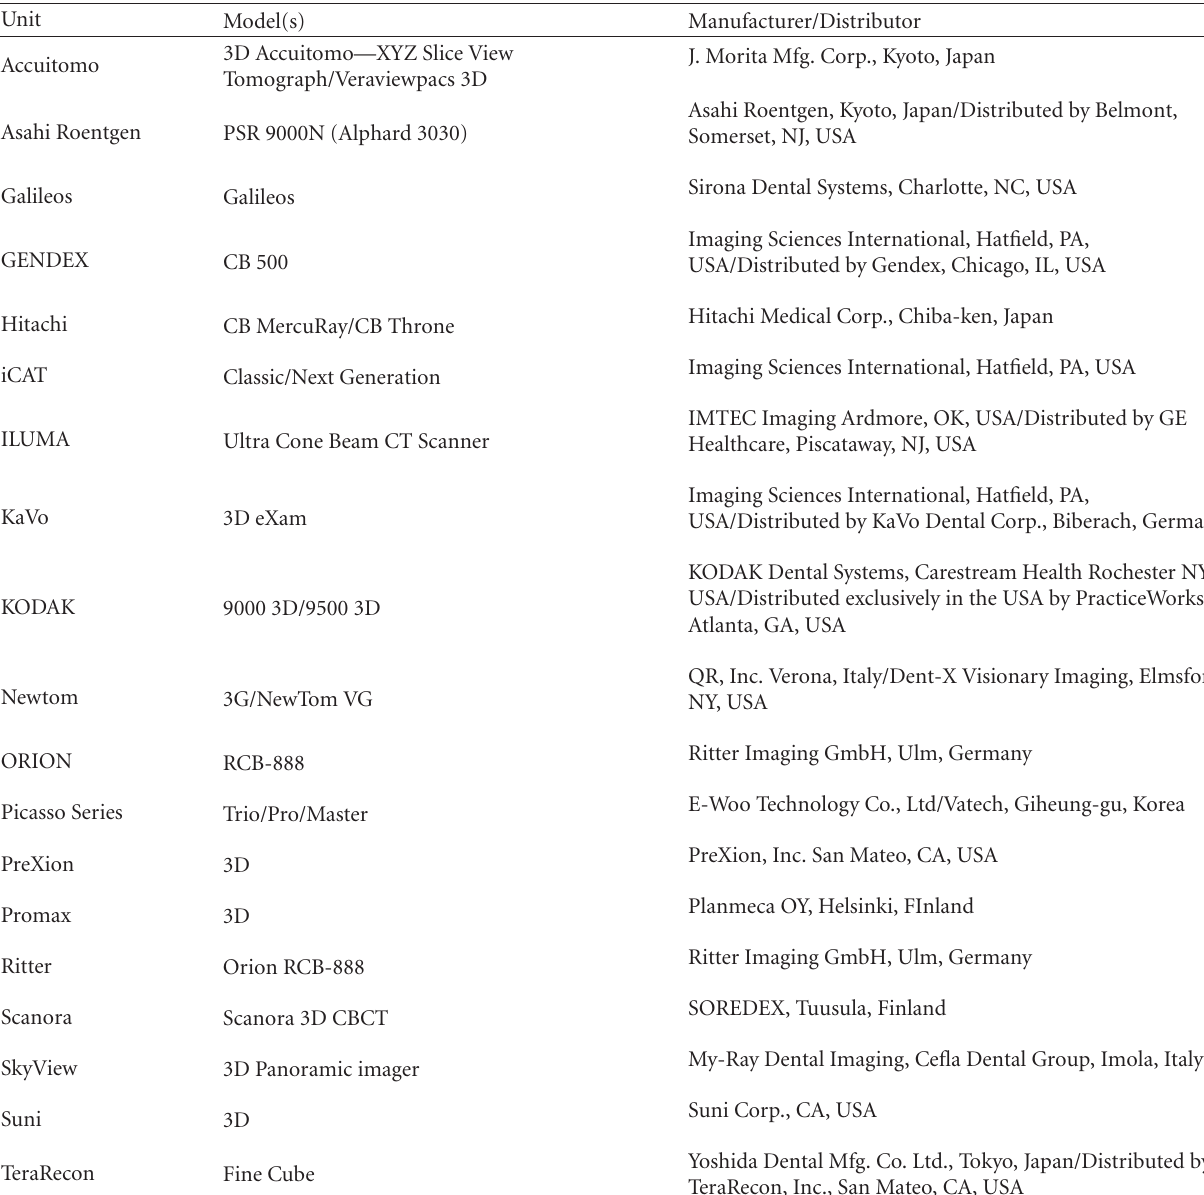
Table 1: Current commercially available CBCT